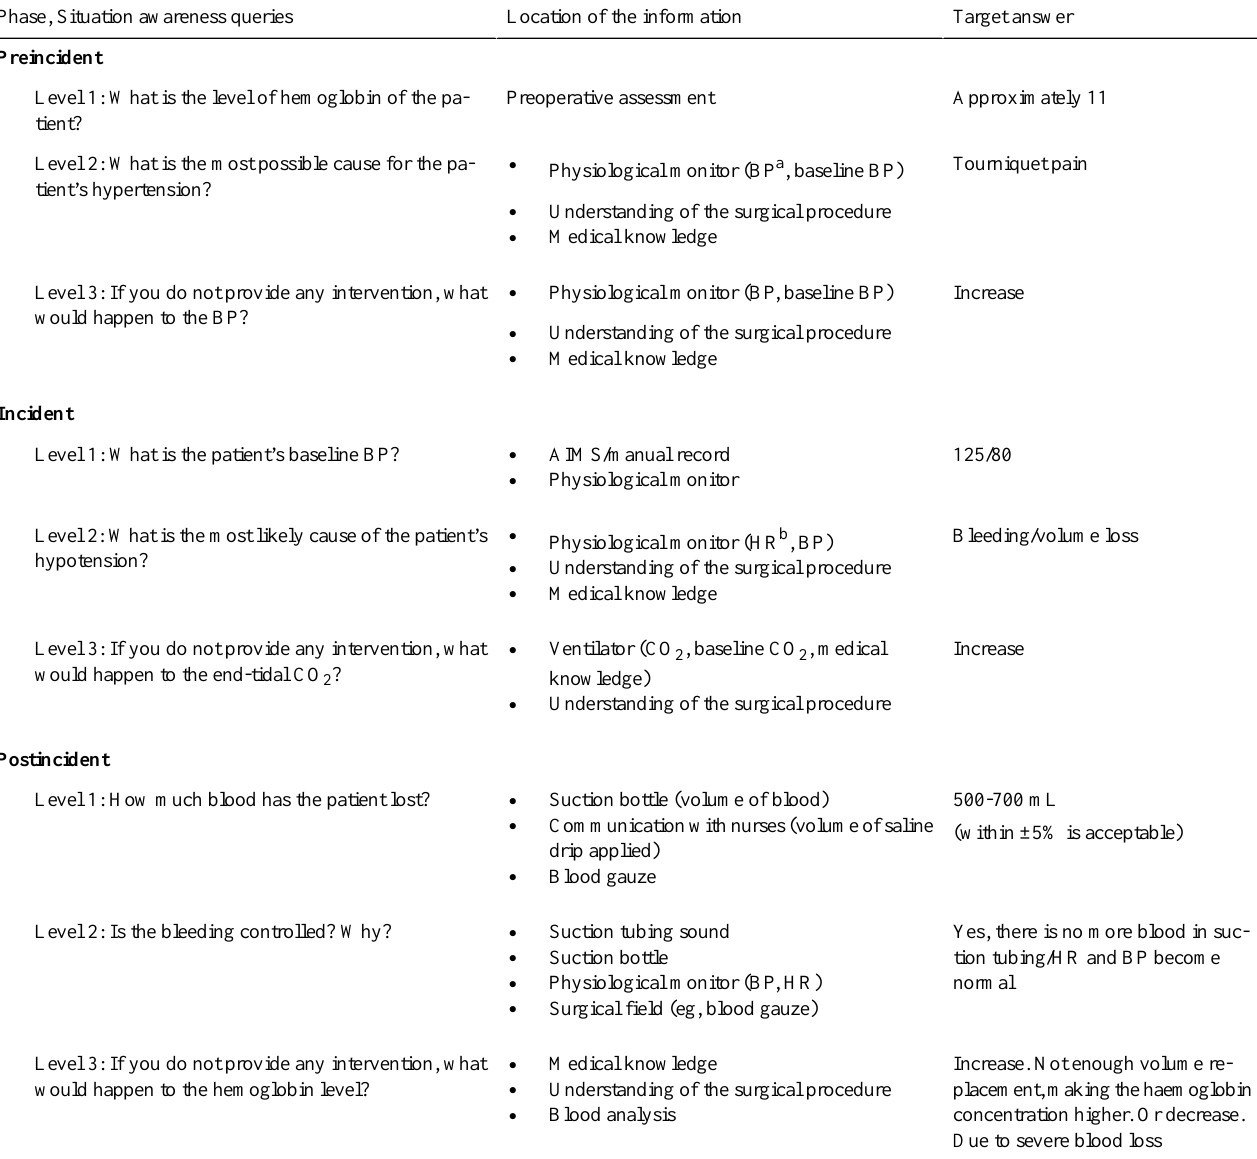
Table 1. The nine situation awareness queries used in the scenario with their locations of information and their target answers.